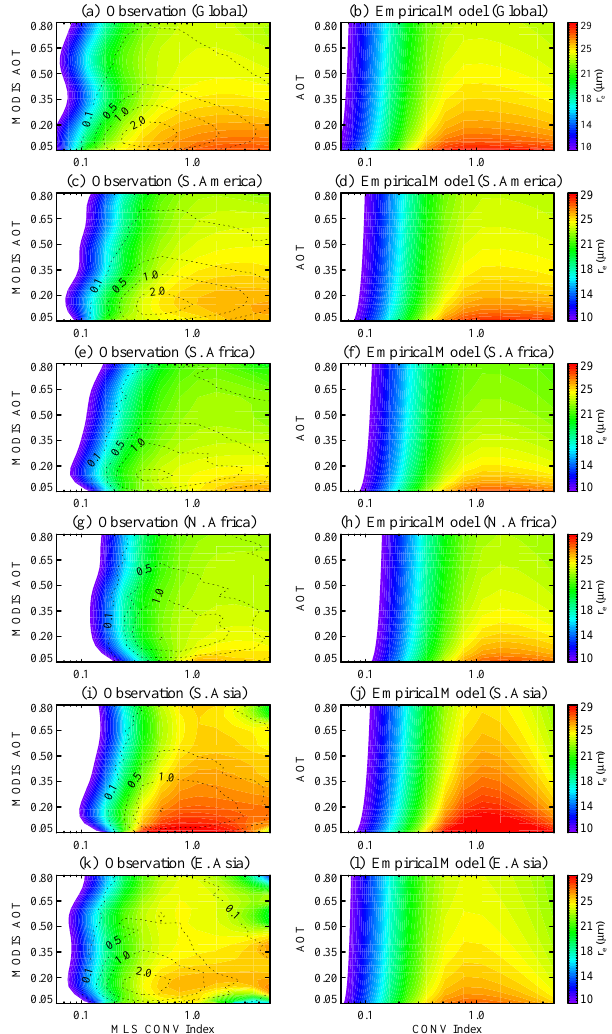
Fig. 3. Left column: Observed r e as a function of CONV and AOT in various regions. The dotted-lines are the occurrence frequency for each CONV-AOT bin. Right column: Computed r e as a function of CONV and AOT based on the empirical models for each region.